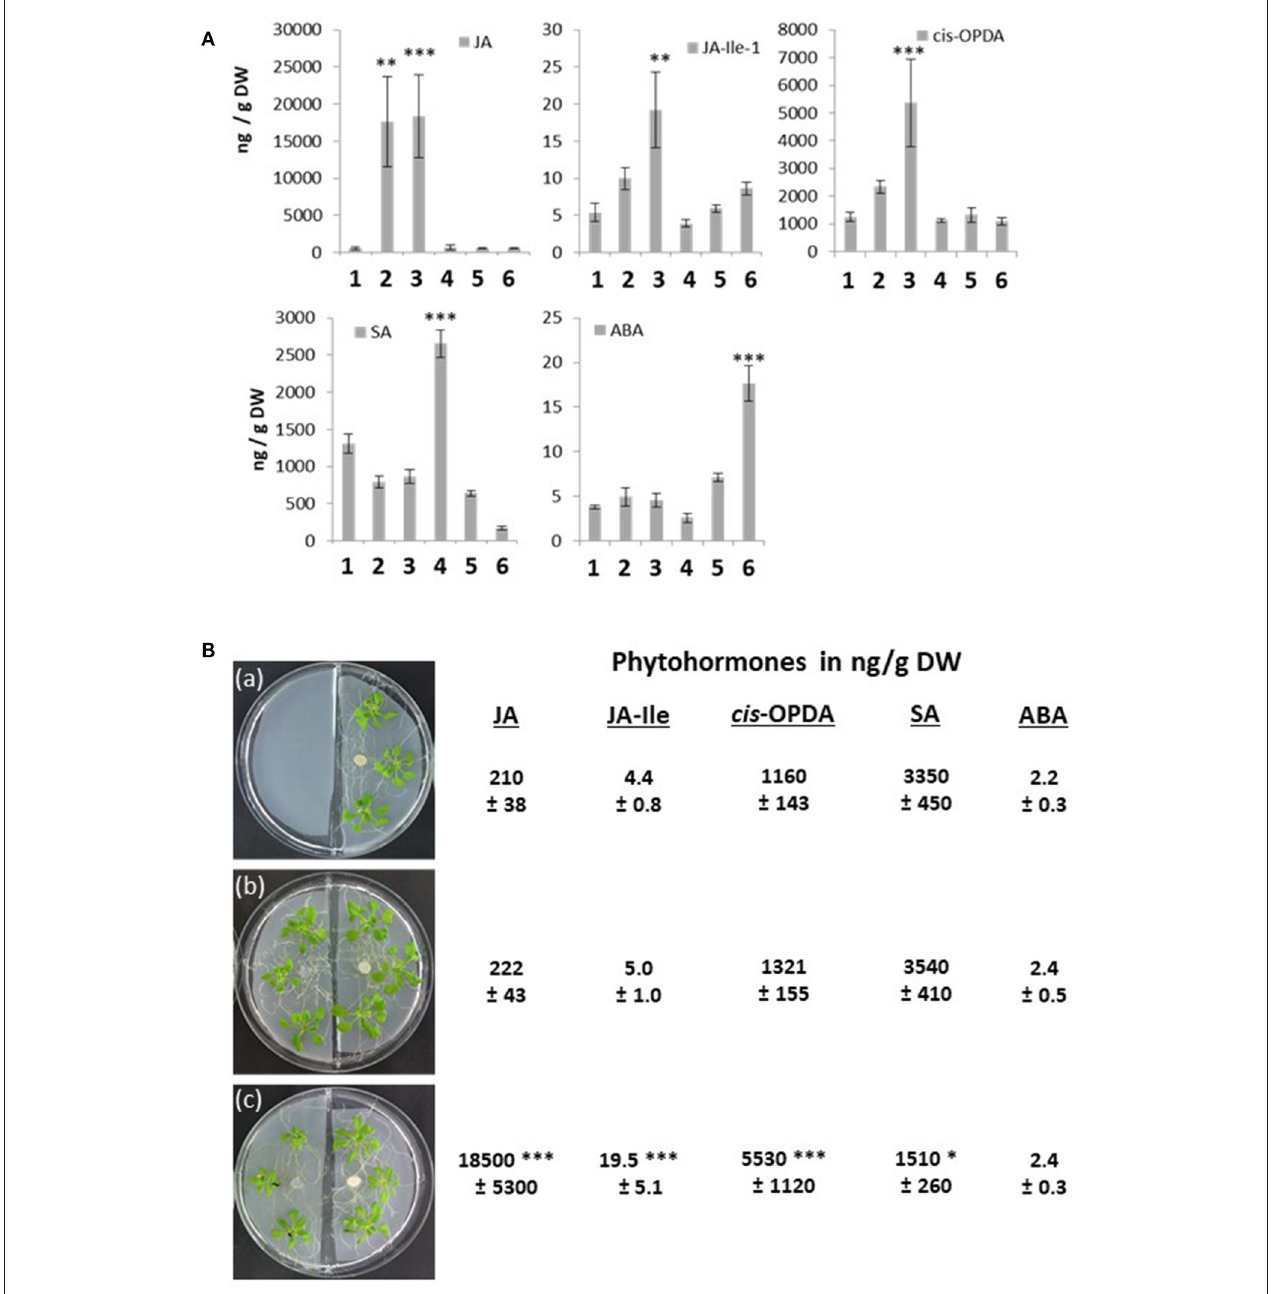
FIGURE 6 | (A) Phytohormone concentrations in ng/g dry weight (DW) in the 6 seedlings (number 1–6) shown in Figure 3A . 1, no treatment; 2, A. brassicae infected material; 3, seedlings grown next to A. brassicae -infected seedlings, 4–6, as 1–3, except that seedlings were connected by a P. indica hyphal network. The experimental set-up is shown in Figure 3A . Based on 5 independent experiments, errors represent SEs. Asterisks indicate significant differences to the values for the untreated seedling number 1, by Student’s t -test (** P ≤ 0,01; *** P ≤ 0.001). (B) Split Petri dish experiment with Arabidopsis seedlings. Left chamber: (a) empty, (b) Arabidopsis seedlings, (c) Arabidopsis seedlings infected with A. brassicae spores for 12 days. The hormone levels were determined for the seedlings grown on the right site in the Petri dish, which were grown in the presence of P. indica for 12 days. Based on 5 independent experiments, errors represent SEs. Asterisks indicate significant differences to the values of experiment (a) , by Student’s t -test (* P ≤ 0.1, *** P ≤ 0.001).